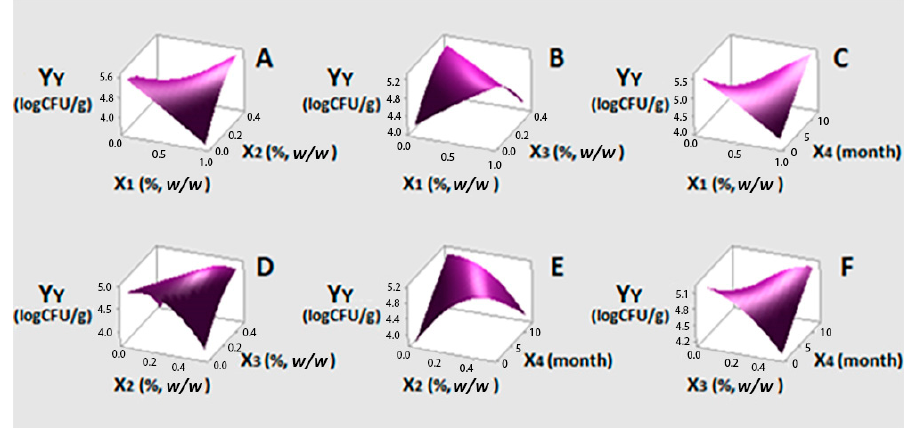
Figure 2. ( A – F ) three-dimensional surface plots for yeasts growth (Y Y , log 10 CFU/g) as a function of oregano (X 1 %, w/w ), lemon balm (X 2 %, w/w ), bay laurel (X 3 %, w/w ) EOs contents and time (X 4 , month). In all cases, the rest factors were kept constant at their middle levels (0.5%, 0.25% and 0.25% w/w and seven months, respectively).